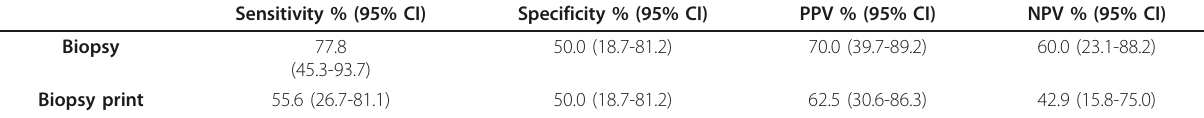
Table 2 Predictive parameters for PCa diagnosis associated to GSTP1 hypermethylation analysis in biopsy and in biopsy print